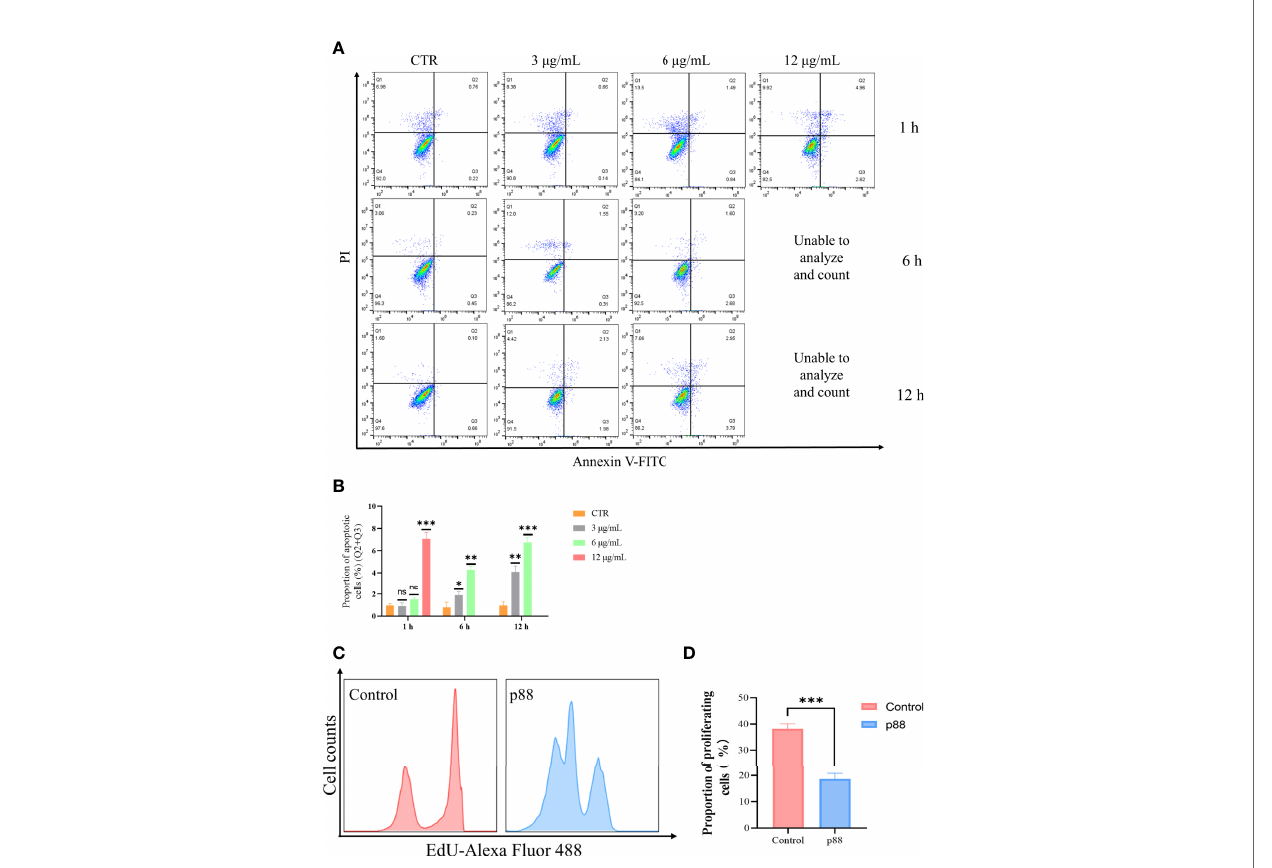
FIGURE 4 | p88 induces apoptosis and inhibits proliferation in GES-1 cells. Representative apoptosis photographs of p88-treated GES-1 cells by fl ow cytometry (A) . Quantitative analysis of apoptosis (Q2 + Q3) (B) . The EdU-Alexa Fluor 488 cell count of 12 m g/ml p88-treated GES-1 cells was detected by fl ow cytometry (C) . Quantitative analysis of proliferation p88-treated GES-1 cells (D) . The asterisks indicate signi fi cant differences from the control. n = 3. * p <0.05, ** p <0.01, *** p <0.001. ns, no signi fi cance.